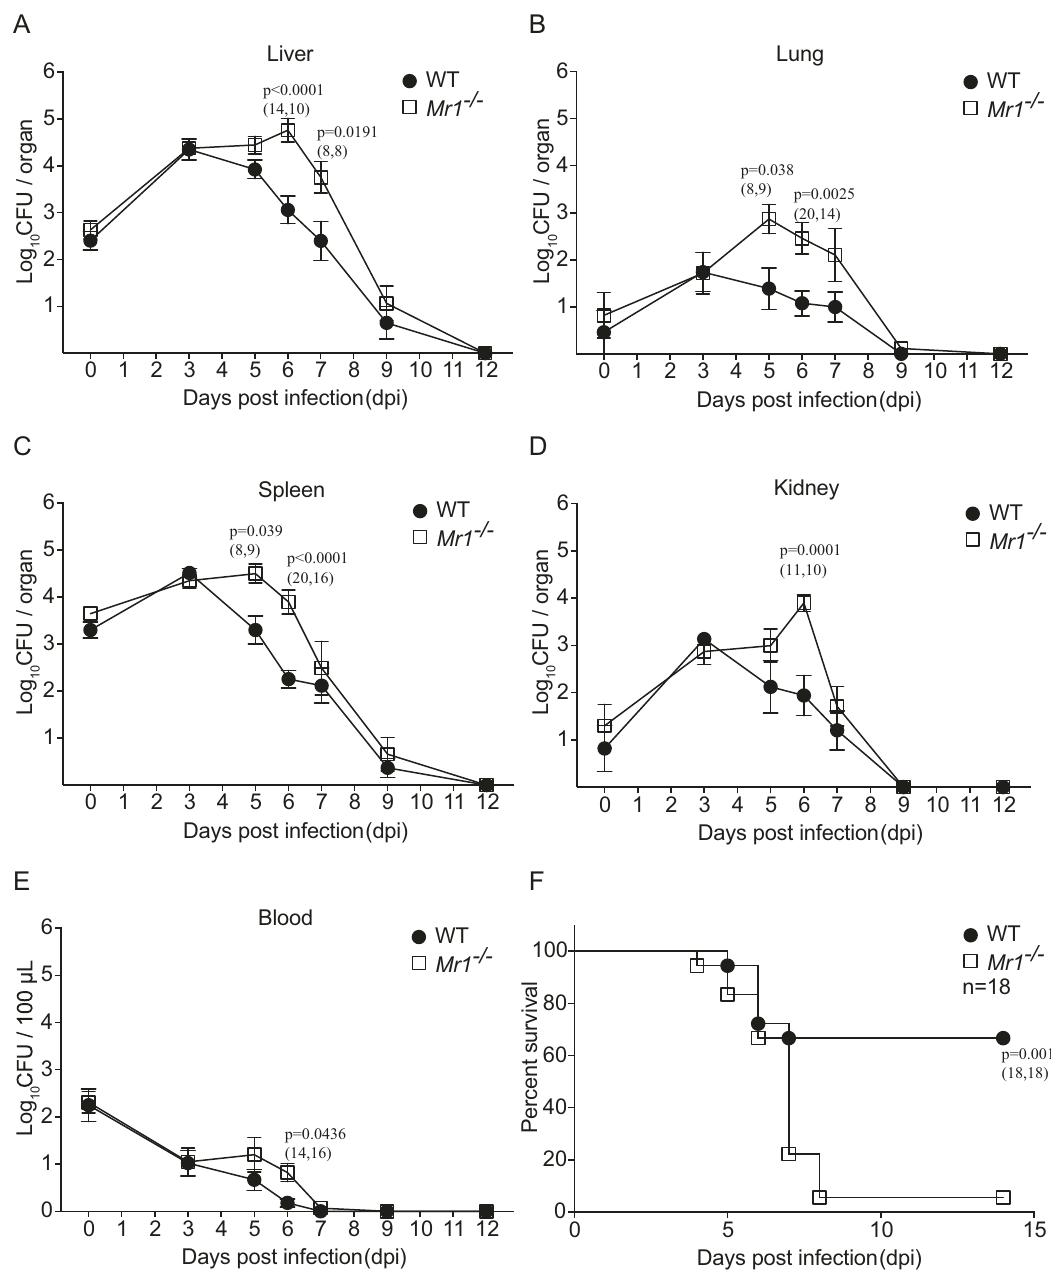
Fig. 6 Systemic control of bacterial load and survival after intravenous F. tularensis infection are enhanced in the presence of MAIT cells. A – E WT (C57BL/6) or Mr1 − / − mice were infected i.v. with 2 × 10 4 CFU F. tularensis LVS. The bacterial burden (CFU) in the liver, lung, spleen, kidney, and blood (100 μ l) was assessed at the indicated dpi. 0 dpi was examined at 4 h after inoculation. Pooled data (mean ± SEM) from two independent experiments with similar results. Two-way ANOVA on log-transformed data. P -values < 0.05 are indicated. Numbers in brackets indicate number of mice: n = (WT, Mr1 − / − ). F Survival of WT (C57BL/6) or Mr1 − / − mice ( n = 18 mice per group) challenged with 2.5 × 10 4 CFU F. tularensis LVS. Log-rank test. P -value is indicated. Source data are provided as a Source Data fi